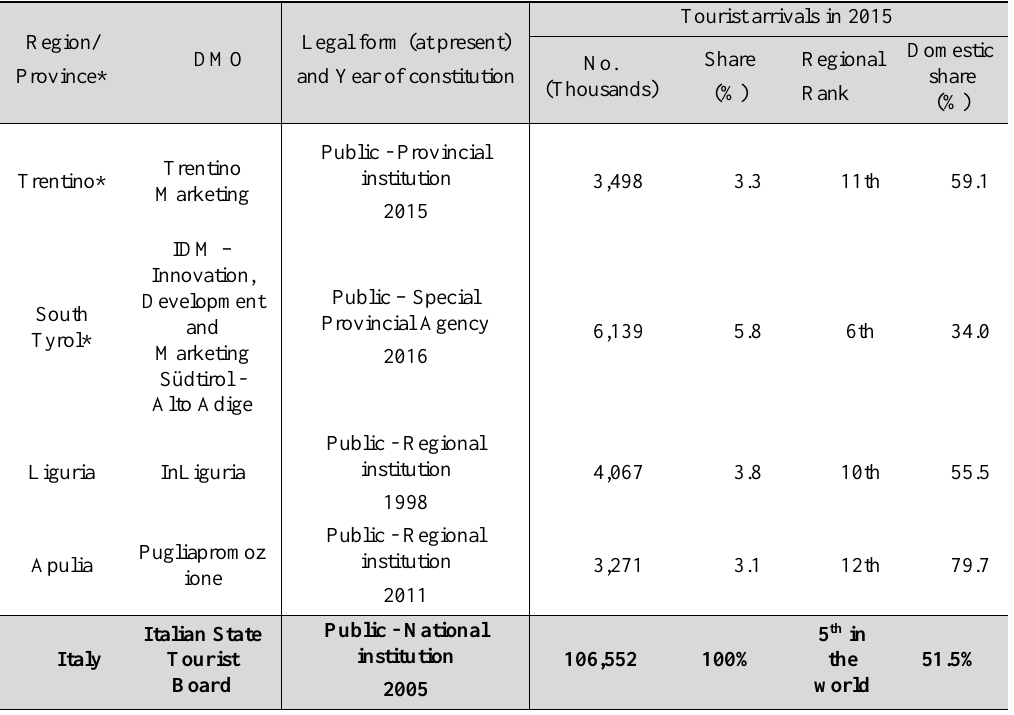
Table 1: Profile of Italian Regional/Provincial